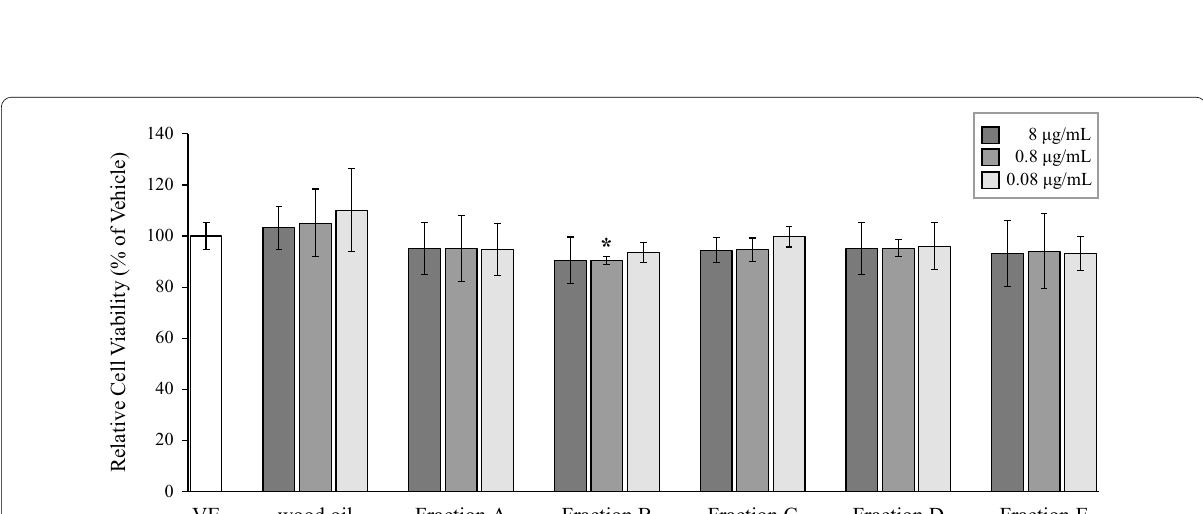
Fig. 3 Effects of the pine wood essential oil and its oil fractions on cell viability. VE: vehicle, DMSO. The results are presented as mean deviations. * p < 0.05 compared to